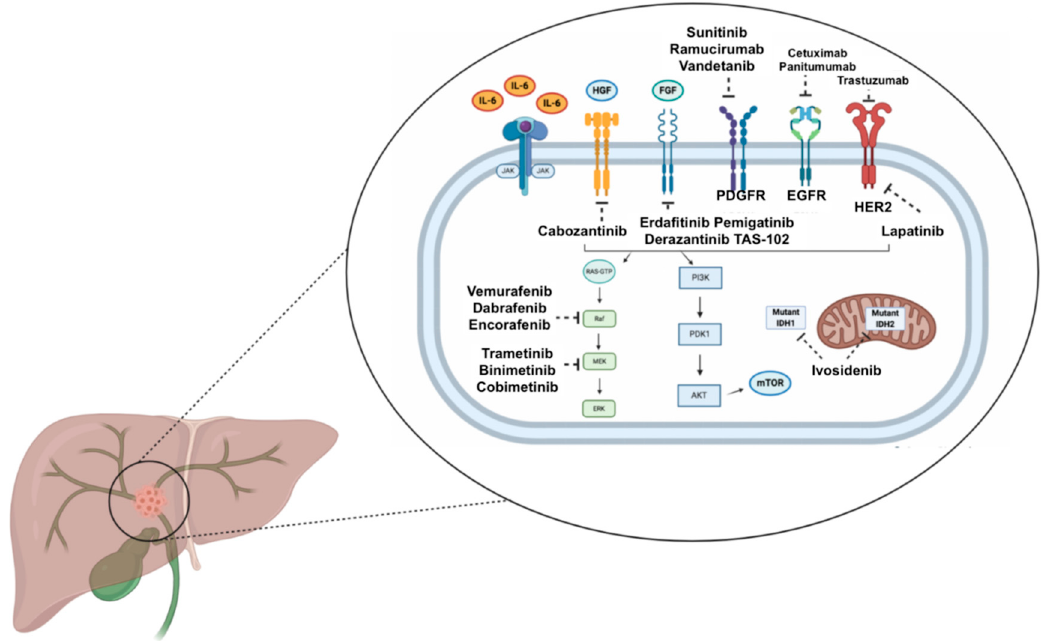
Figure 1. Schematic figure representing the main signaling pathways and selected targeted therapies currently under evaluation in cholangiocarcinoma. Abbreviations: AKT: protein kinase B; EGFR: epidermal growth factor receptor; FGF: fibroblast growth factor; HER2: epidermal growth factor receptor 2; HGF: hepatocyte growth factor; IL-6: interleukin 6; IDH: isocitrate dehydrogenase; JAK: Janus kinase; mTOR: mammalian target of rapamycin; PDGFR: platelet derived growth factor receptor; PDK1: phosphoinositide-dependent kinase-1; PI3K: phosphoinositide 3-kinase.